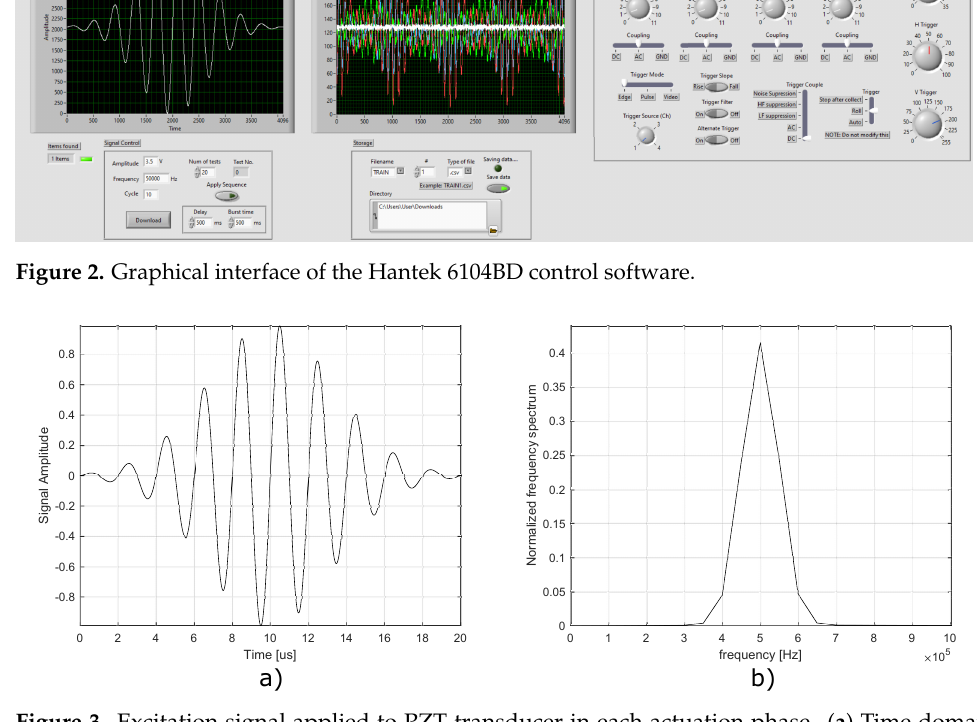
Figure 3. Excitation signal applied to PZT transducer in each actuation phase. ( a ) Time domain. ( b ) Frequency